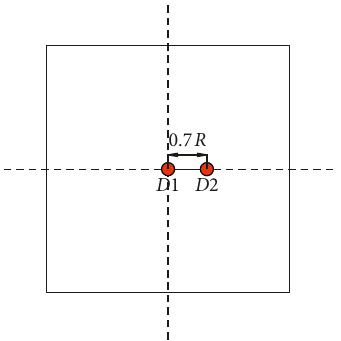
Figure 7: The position of measuring points. Table 4: The relevant parameters for material strength [46]. A B C